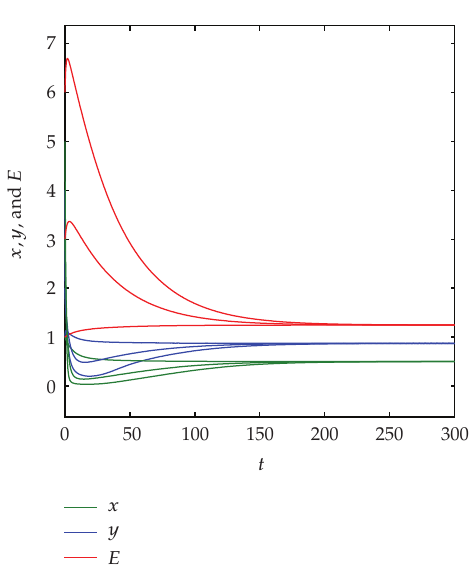
Figure 6: Solution curves of system (cid:6) 4.1 (cid:7) with the parameters given by Example 6.2 when r 1 (cid:8) 1.